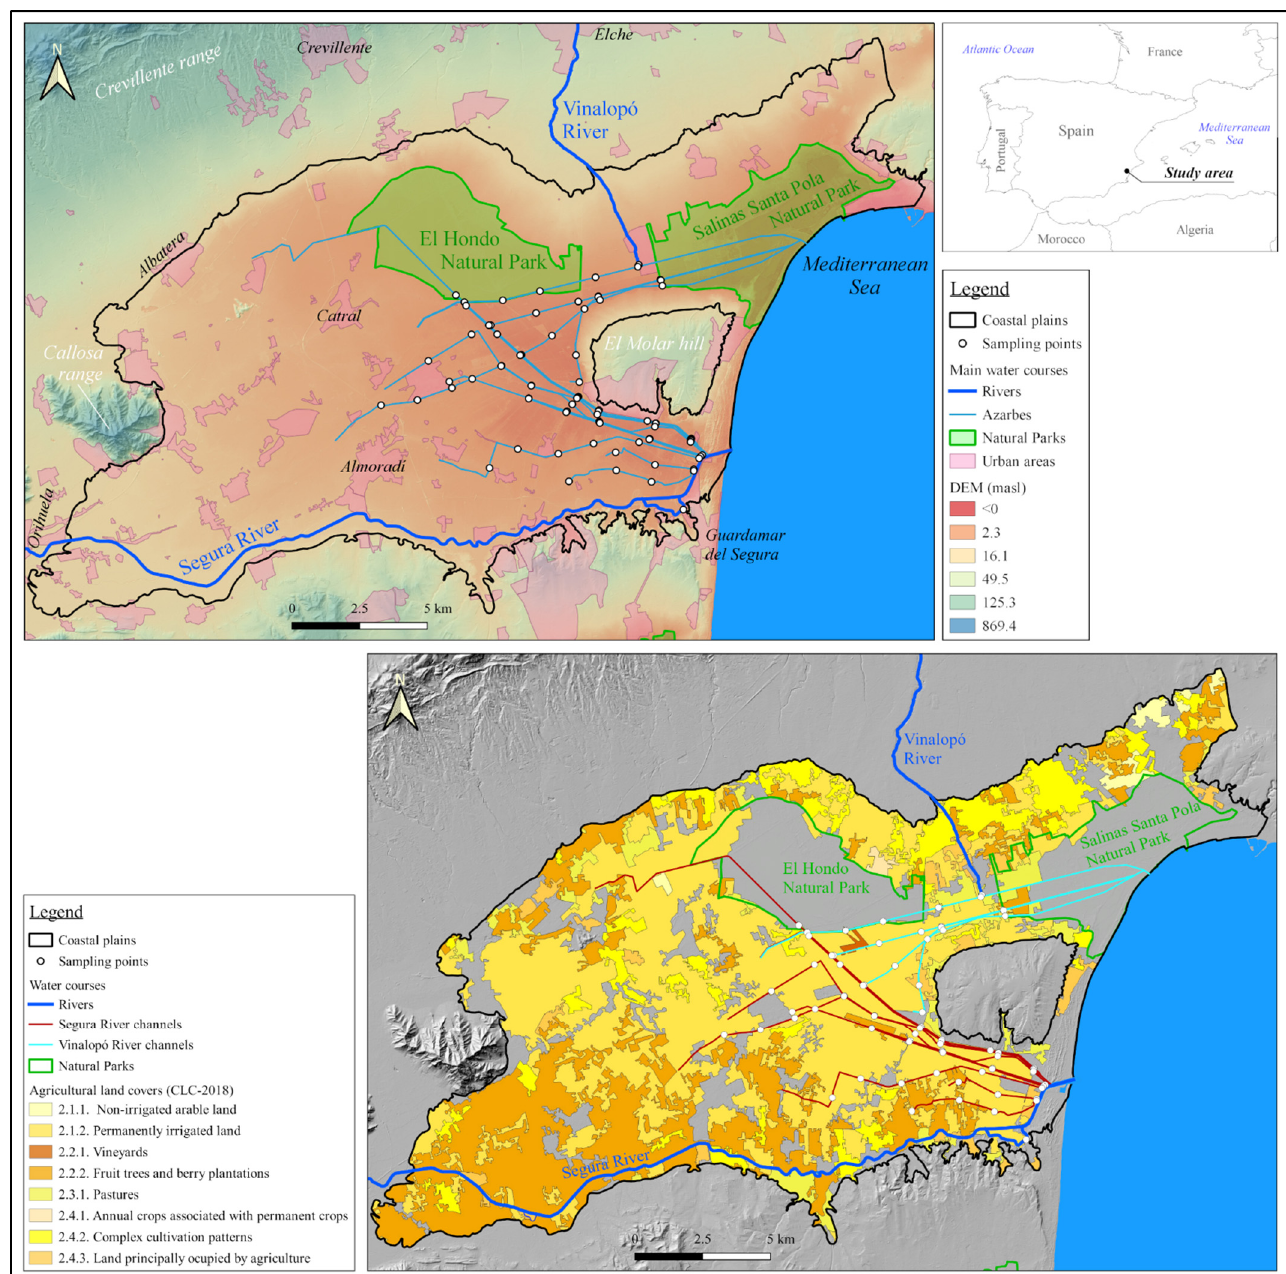
Figure 1. Descriptive maps of the study area: ( upper ) location of the study area showing the main populated areas (e.g., Almoradí); the digital elevation model (DEM), main water courses (natural and artificial, e.g., azarbes, which is the drainage network) and the location of the sampling points. ( Lower ) agricultural land covers at the study area; irrigation channels associated to each river are shown with different colors.